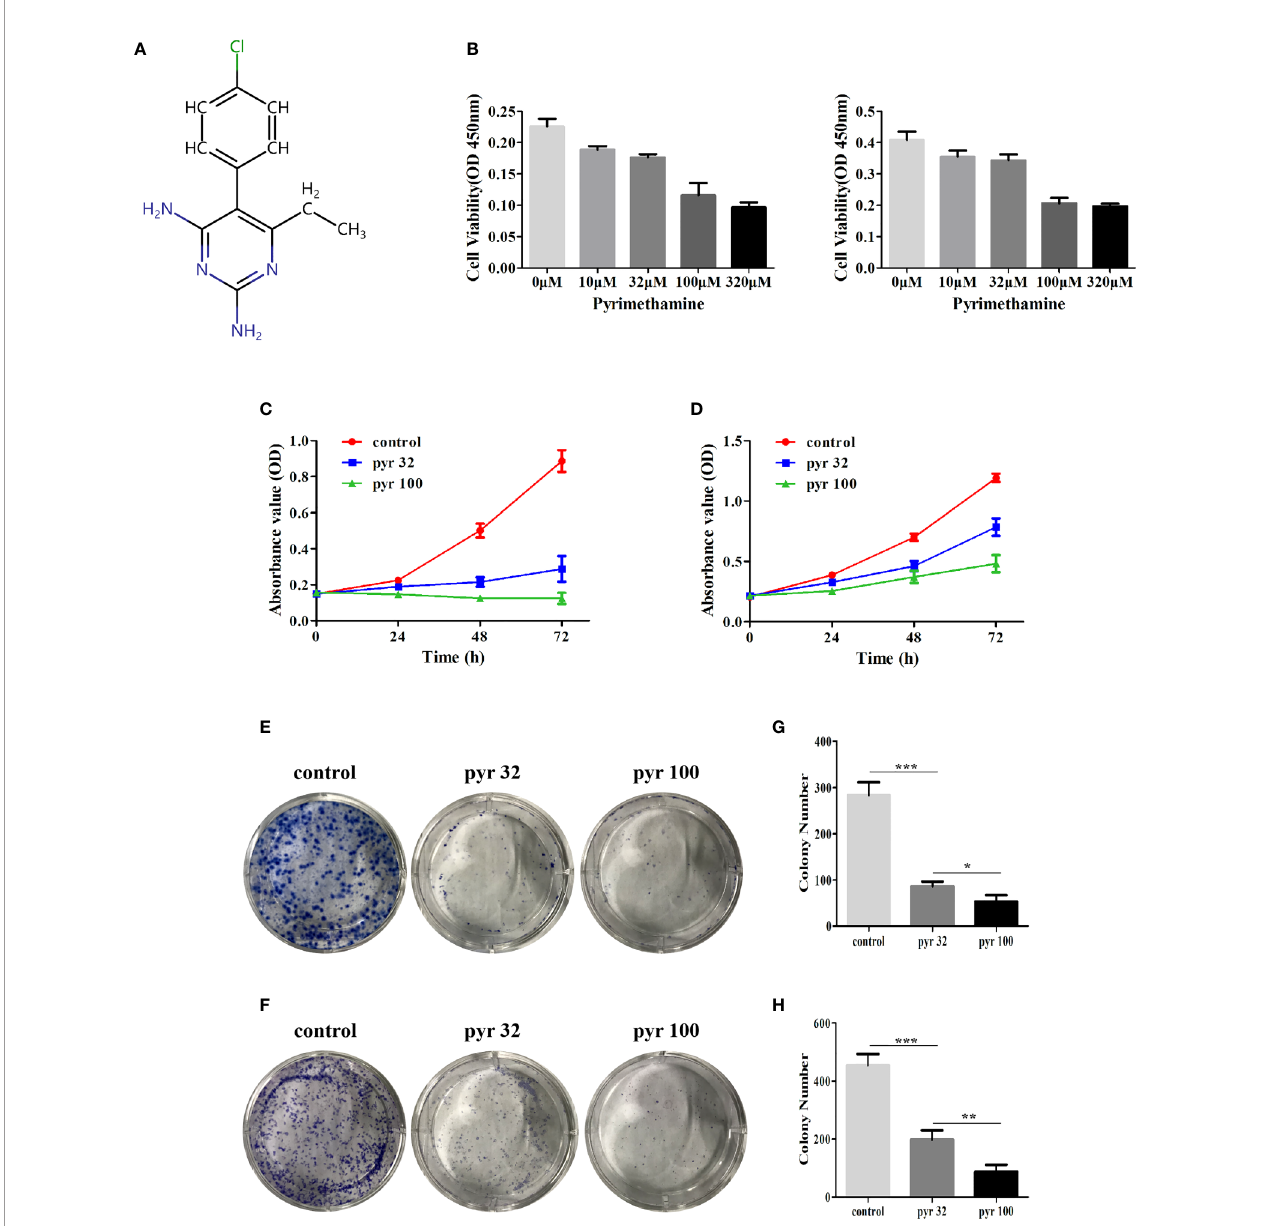
FIGURE 1 | Pyrimethamine inhibits the cell proliferation in human CRPC cells. (A) Chemical structure of pyrimethamine. (B) The changing 50% inhibitory concentrations of pyrimethamine fi tting in DU145 (left) and PC3 (right) cells. (C, D) Pyrimethamine inhibits the proliferation of DU145 (C) and PC3 (D) cells as detected by CCK-8 assays. (E, F) Representative images of the DU145 and PC3 cell colonies after treatment of 0, 32, and 100 m M pyrimethamine were shown. (G, H) Mean colony numbers ± SD were shown. Each bar represents the mean ± SD of three independent experiments. * P < 0.05; ** P < 0.01 ; *** P <